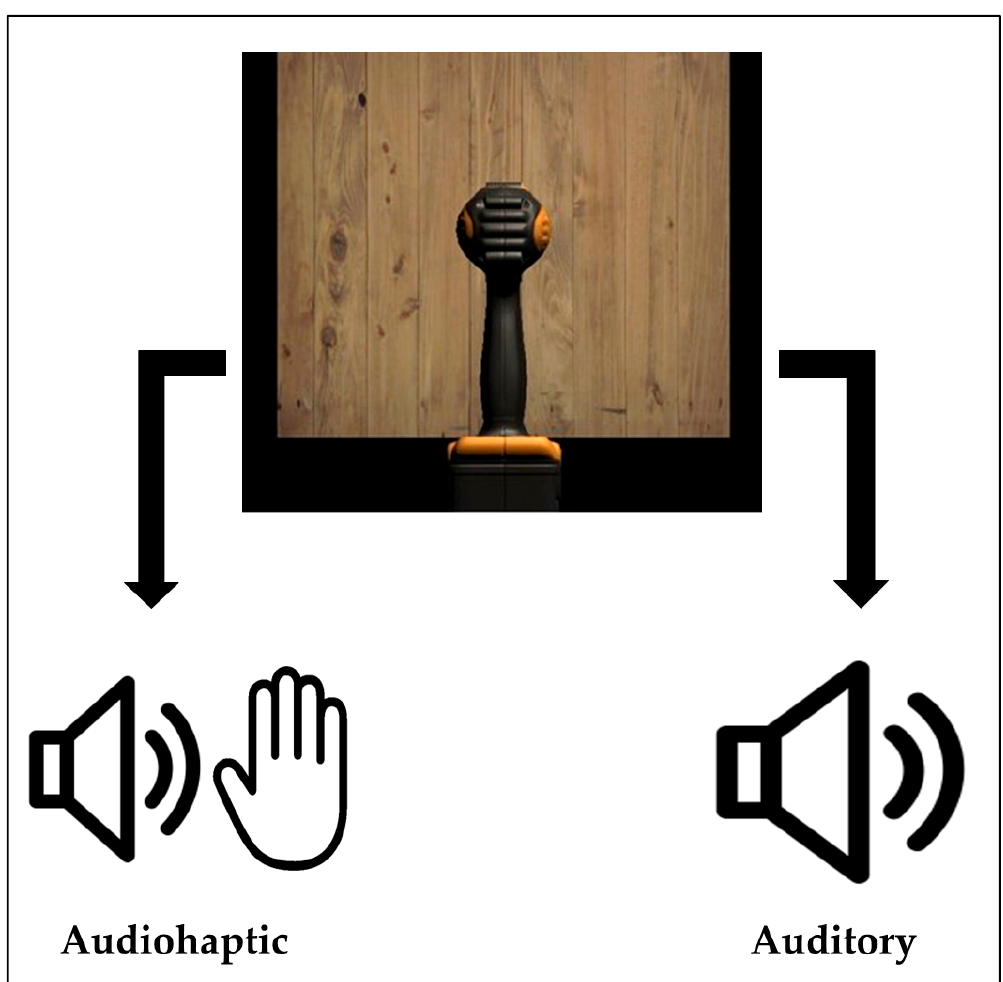
Figure 1. Stimulus conditions presented in each trial type (audiohaptic or auditory alone).